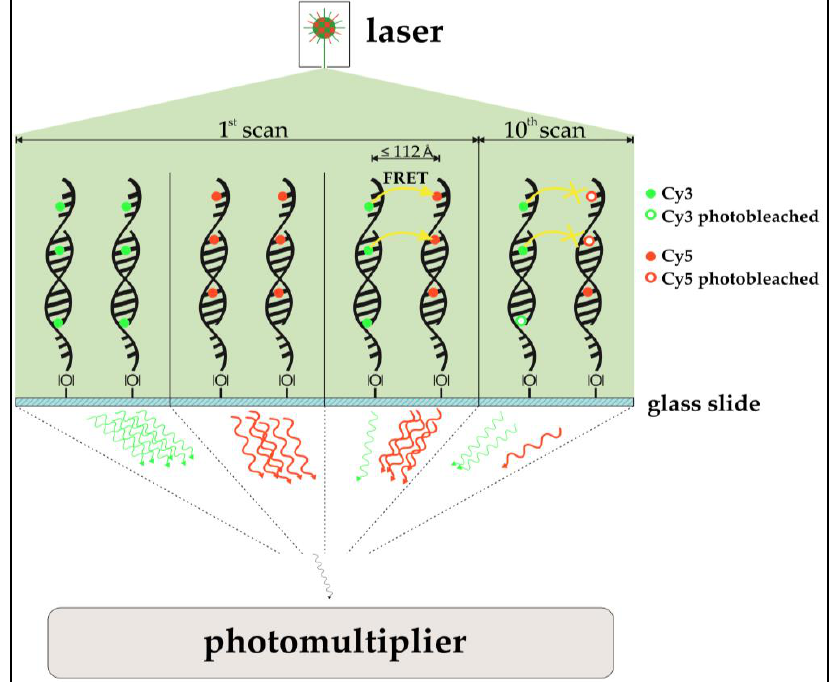
Figure 2. Schematic model of a hypothesized Förster-resonance-energy-transfer (FRET)-effect in cyanine-labeled two-dye DNA microarray scanning. Cyanine-labeled DNA in single-dye setups emits photons after excitation (upper left, upper mid left). In a two-dye setup at the first scan (upper mid right), Cy3 only partially emits photons after excitation. With Cy5 in it vicinity, Cy3 acts as a FRET donor, transferring the energy to the Cy5-acceptor, which itself emits a photon. This leads to a lower Cy3 signal and a higher Cy5 signal compared to Cy3 and Cy5 from single dye setups. After several scans, photobleaching should have decreased the amount of functional, photon-emitting cyanine molecules. While this would be observable in single dye setups (not shown), one does actually observe a different behavior in two-dye setups (upper left). The higher bleaching susceptibility of Cy5 decreased the chance of Cy3 acting as a FRET-donor, simultaneously increasing the amount of emitted photons from Cy3. While a strong decrease in Cy5-photon emission can be observed, the emission of Cy3 seems to have “increased”. This effect is called passive “de-quenching”. All emitted photons then enter the photomultiplier (PMT), where they are transformed into an exponentially enhanced electron